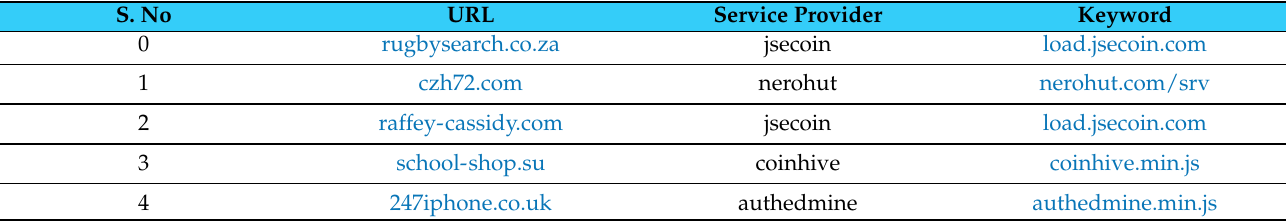
Table 2. Example of Some Malicious